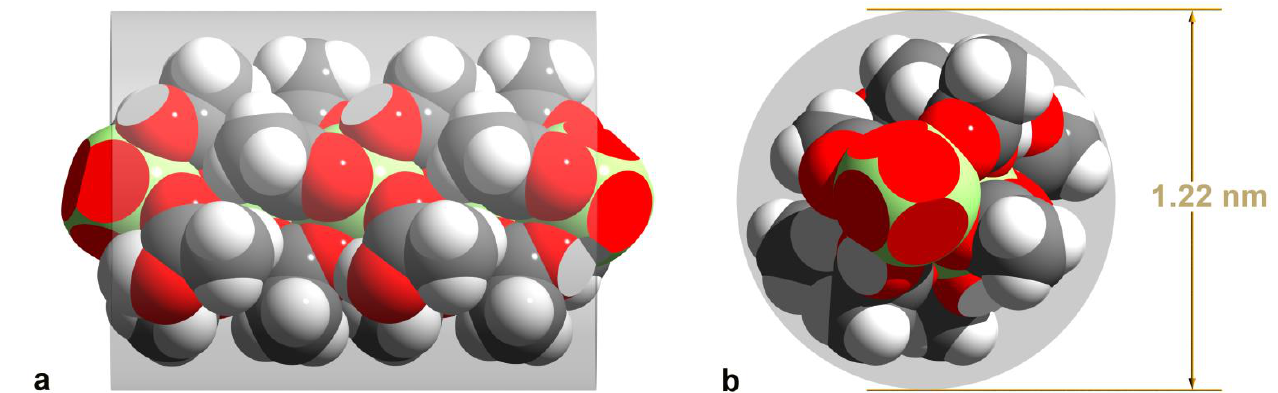
Figure 9. Space-filling model showing a section of the one-dimensional coordination polymer in the RE(OAc) 3 · 2AcOH structure type illustrating its rod-like shape when omitting the uncoordinated acetic acid molecules; example RE = Nd, positions of subsequent oxygen atoms are visualized by their sectional plane with the RE-spheres in red as are the position of the uncoordinated acetic acids molecules by their sectional planes with the acceptor oxygen atom in red. Color code: oxygen = red, carbon = black, hydrogen = white, neodymium = yellow-green. ( a ) side-view, ( b ) front view.